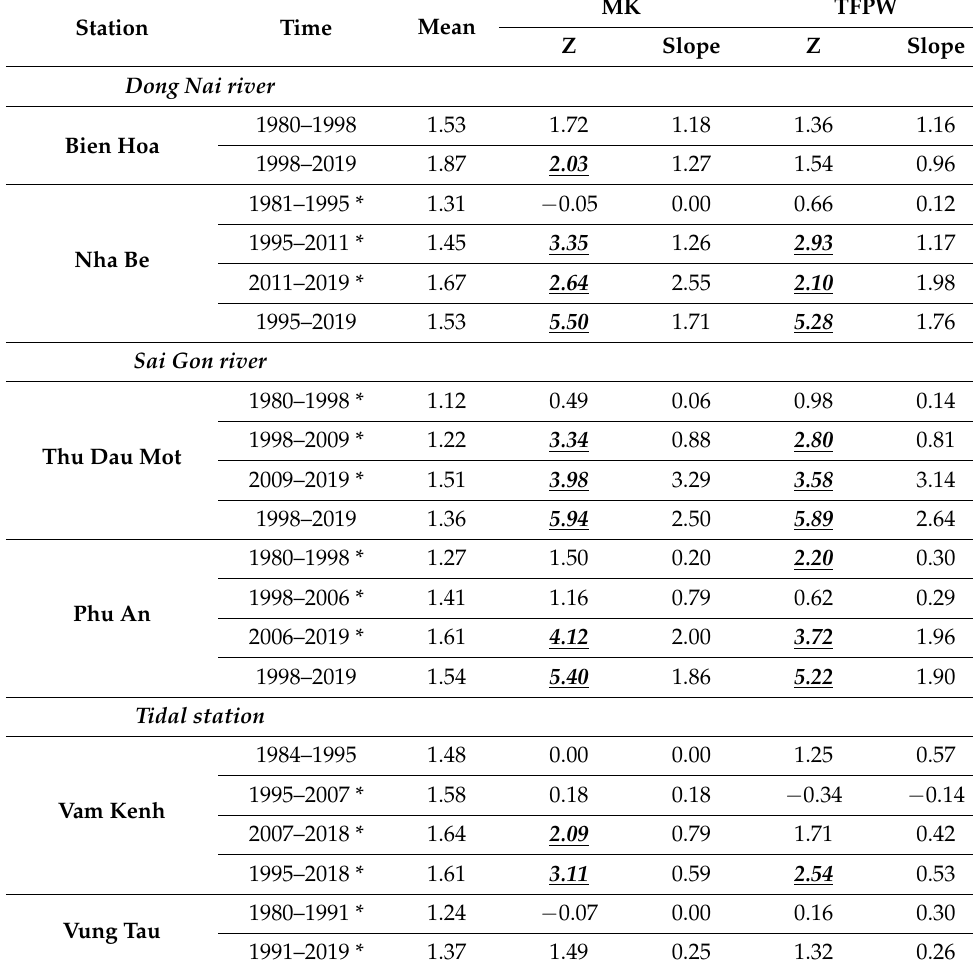
Table 6. The periodic water level trend at H max .